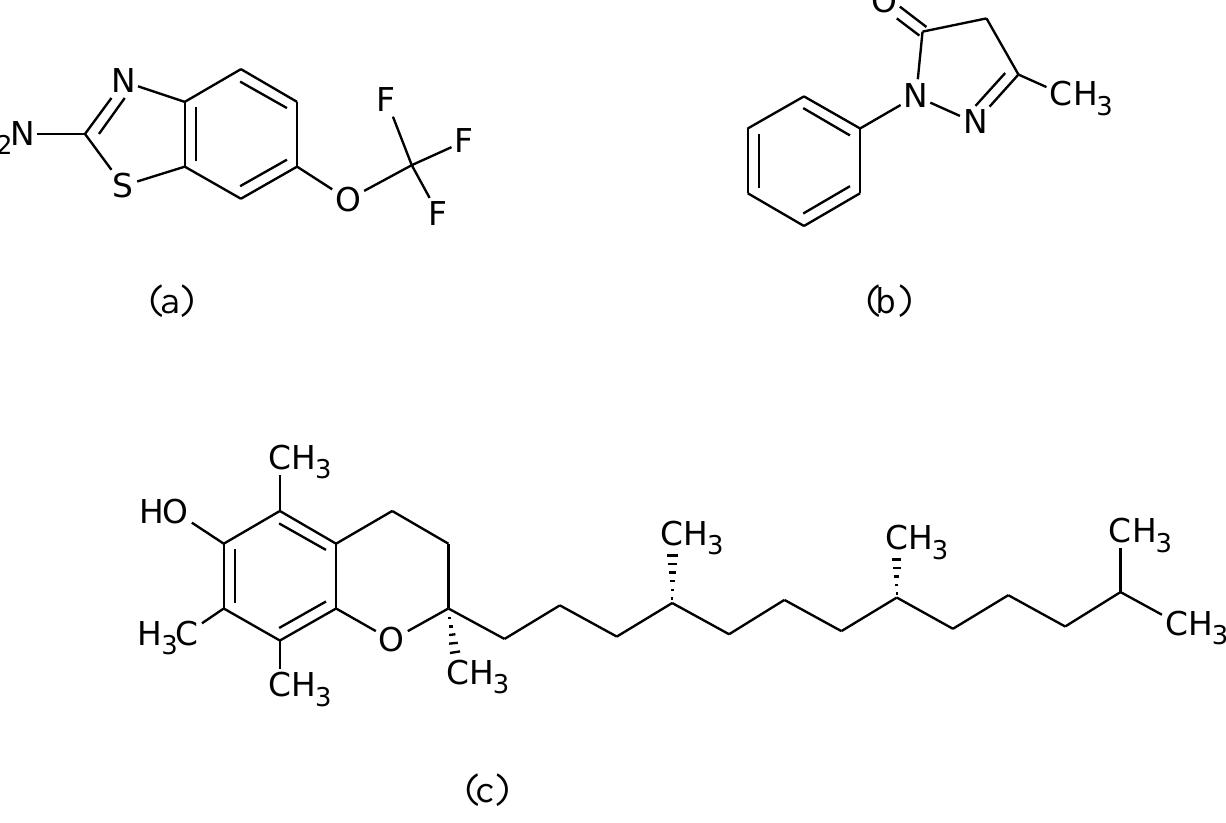
Figure 12. Chemical formula of ( a ) riluzole, ( b ) edaravone and ( c ) vitamin E. Vitamin E (Figure 12c) has been shown to be effective in delaying ALS onset in the mouse model, but it was found to be ineffective in some patients with ALS [174]. It remains likely that vitamin E supplements in healthy people may reduce or delay the risk of ALS